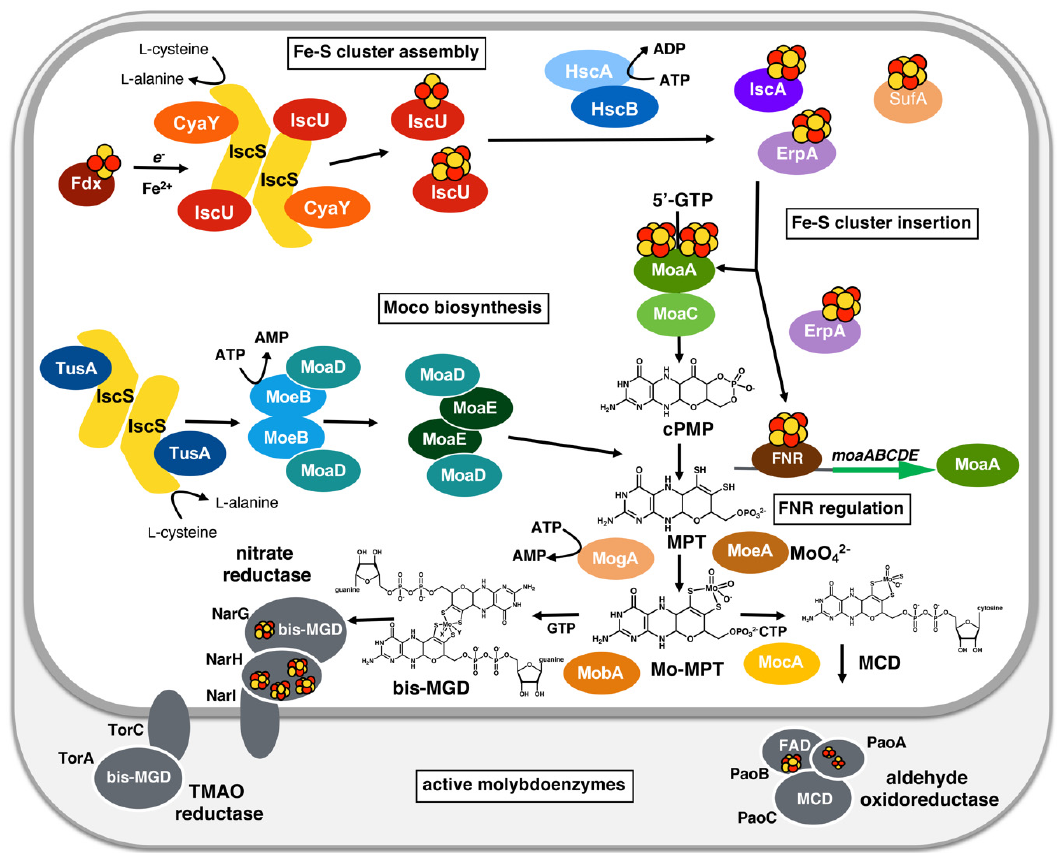
Figure 4. Moco biosynthesis and the link to Fe-S cluster assembly in E. coli . In Moco biosynthesis, Mo-MPT is formed from 5 ′ GTP with cPMP and MPT as stable intermediates. For enzymes of the DMSO reductase family like TorCA or NarGHI, bis-MGD is formed by the addition of GMP to each MPT unit in the bis-Mo-MPT intermediate. For enzymes like PaoABC, Mo-MPT is further modified by the addition of CMP to form the MCD form of the cofactor. Molybdoenzymes, in general, are complex enzymes, containing additional cofactors like FAD, Fe-S clusters, or hemes. The sulfur for the synthesis of the dithiolene group in Moco is mobilized by IscS with the additional involvement of the TusA protein. CyaY interacts with the IscS-IscU complex and forms a central heterotetramer. Fe-S clusters assemble on the scaffold protein IscU, which receives the sulfur from the L -cysteine desulfurase IscS. Assembly and release of the clusters is catalyzed by the chaperones HscAB. Ferredoxin is delivering the electrons. The carrier proteins IscA and ErpA deliver the matured Fe-S clusters to recipient protein among which is MoaA in Moco biosynthesis.